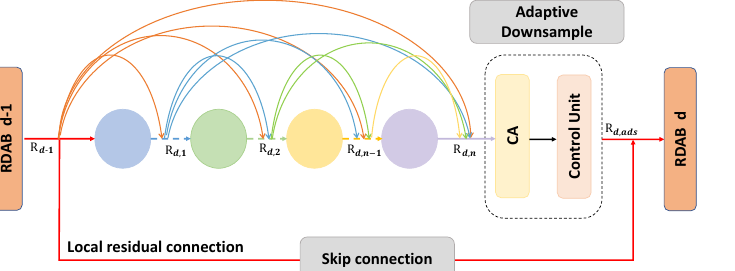
Figure 4. Structure of RDAB. The RDAB module consists of a dense connection block, a skip connection and an adaptive downsampling